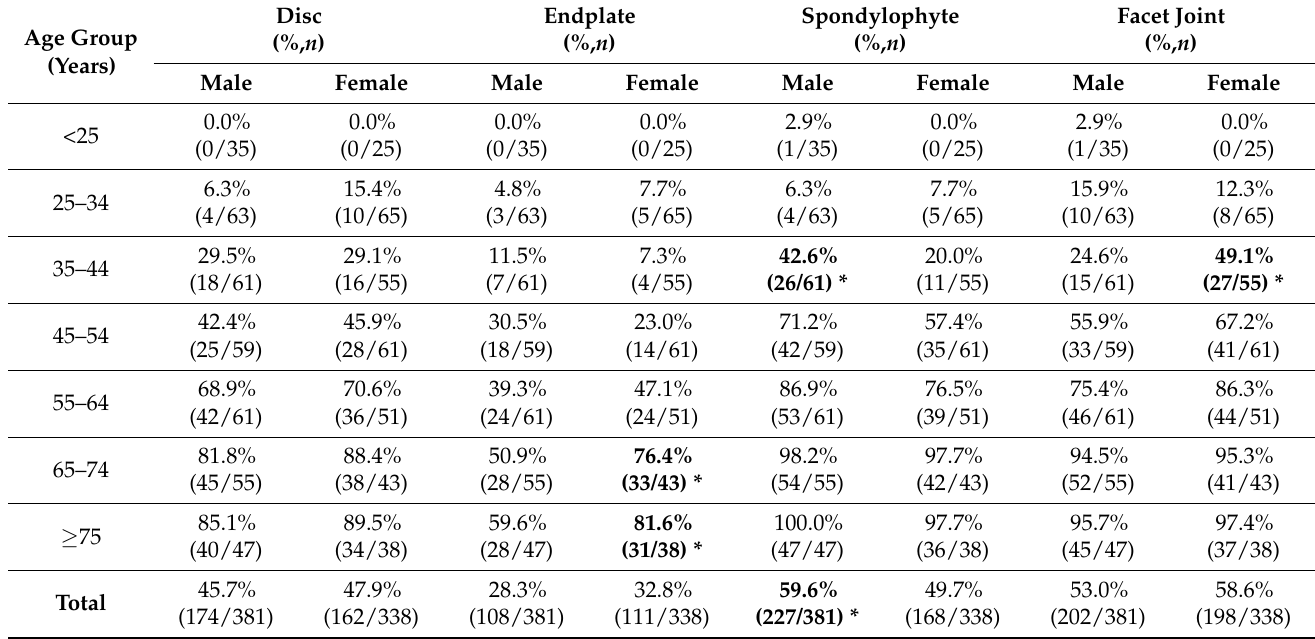
Table 2. Frequency of degenerative lesions per age group. Relative and absolute frequencies. Signifi- cantly higher frequencies compared to opposite sex are printed bold and marked with an asterisk (*); p -values were derived from Chi 2 test.